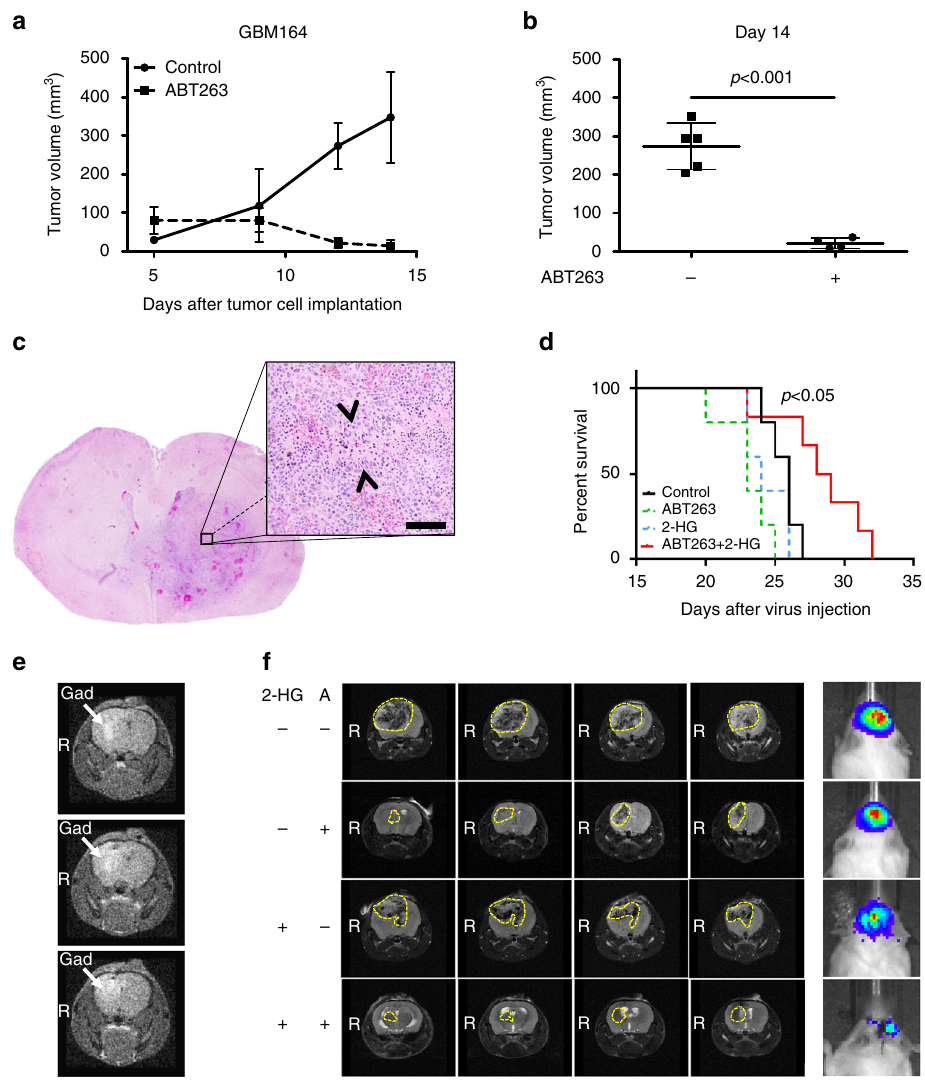
Fig. 7 Treatment with ABT263 in combination with 2-HG prolongs survival in a mouse model generated by orthotopic injection of PDGF-IRES-Cre retrovirus. a GBM164 cryomush was implanted subcutaneously. After tumor formation, animals were randomized into two groups ( n = 4 – 5 tumors per group) and treated intraperitoneally with vehicle or ABT263 75 mg kg − 1 three times a week. b Scatter plot indicating the tumor size of animals treated as described for a on day 14 after tumor cell implantation. a , b Data are presented as mean and SD. c Representative microphotograph of a tumor bearing brain from a mouse treated with vehicle (H&E, 2× magni fi cation) and microphotograph at higher magni fi cation. Arrow heads indicate the formation of pseudopalisading necrosis. Scale bar : 50 µ m. d Kaplan – Meier curves of animals treated with vehicle ( n = 5; median survival = 26 days), ABT263 intraperitoneally 100 mg kg − 1 3× per week ( n = 5; median survival = 23 days), 10 mM 2-HG by convection-enhanced delivery for 7 days ( n = 5; median survival = 24 days) or ABT263 and 2-HG combined ( n = 6; median survival = 28.5 days). Statistical comparison of survival curves was performed using Log-rank (Mantel-Cox) test. e Sequential representative brain MRI scans showing the intracerebral accumulation of Gadolinium after